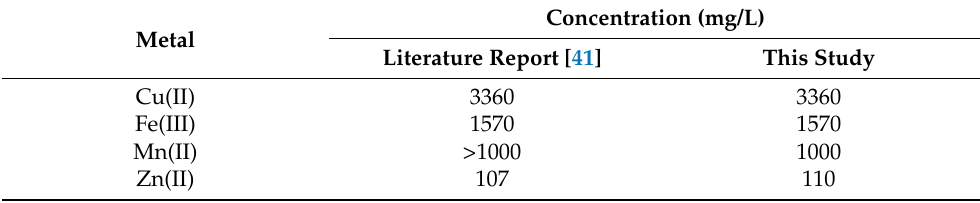
Table 1. Concentration of metals in PLS.